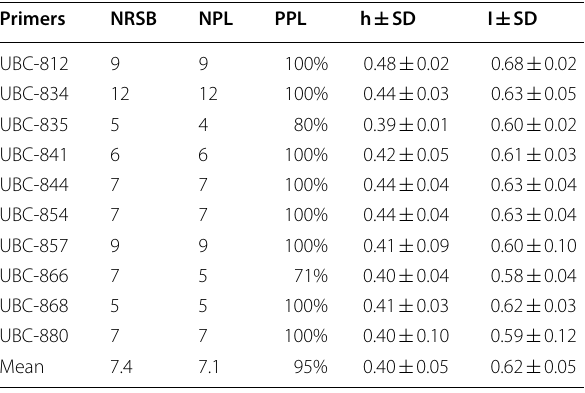
Table 3 Number of reproducible scored bands (NRSB), number of polymorphic loci (NPL), percent of polymorphic loci (PPL), Nei’s gene diversity (h), and Shannon’s information index (I) scored over the entire nine populations studied